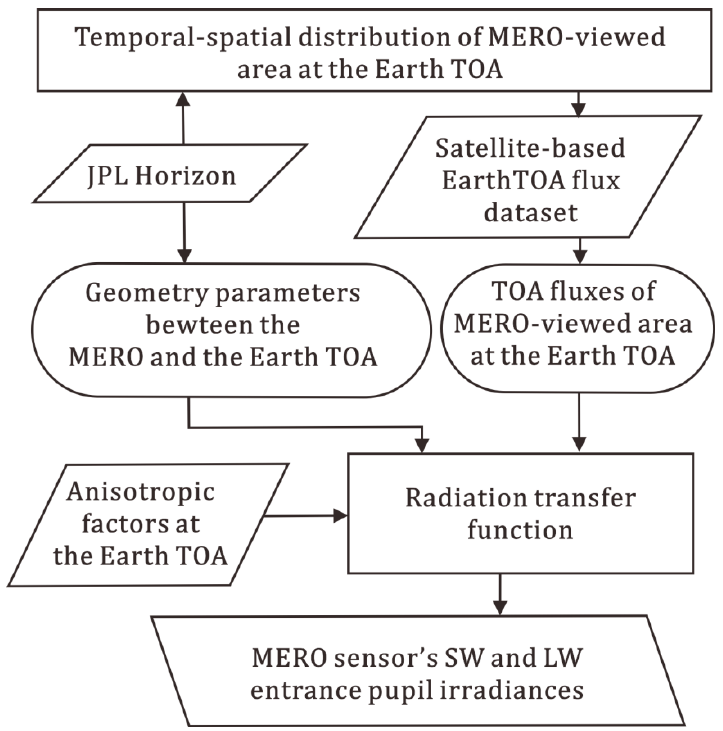
Figure 2. Flowchart of the model construction for deriving a MERO sensor’s entrance pupil irradiances. SW: shortwave; LW: longwave.